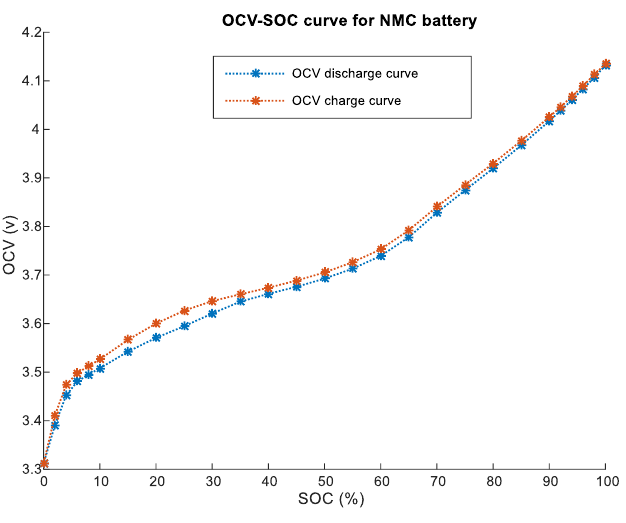
Figure 4. Experimental SOC-OCV curves at 25 ◦ C.